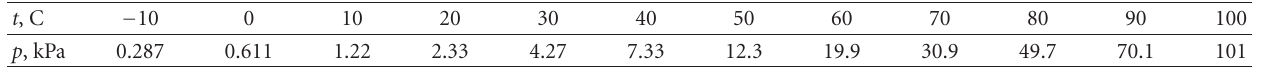
Table 5: Maximum partial pressure of water vapor in atmosphere for given air temperature (pressure is 1atm).